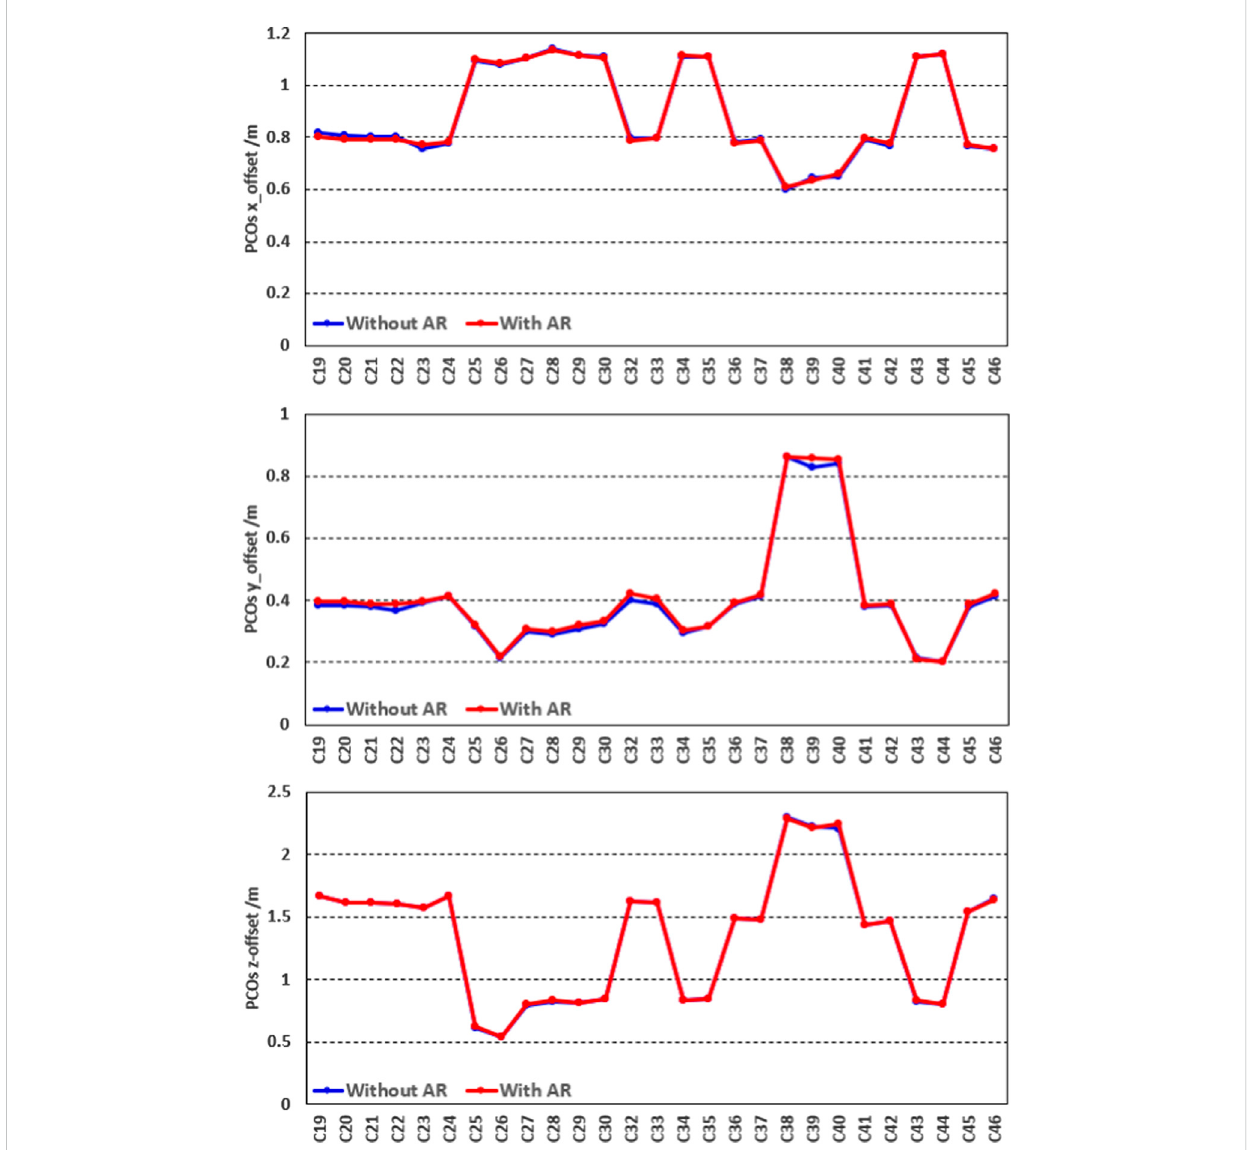
FIGURE 4 Statistical RMS values of PCOs in the x-component (upper panel), y-component (middle panel), and z-component (bottom panel) with ambiguity resolution (the red line) and without ambiguity resolution (the blue line), respectively, for all BDS-3 satellites during 14